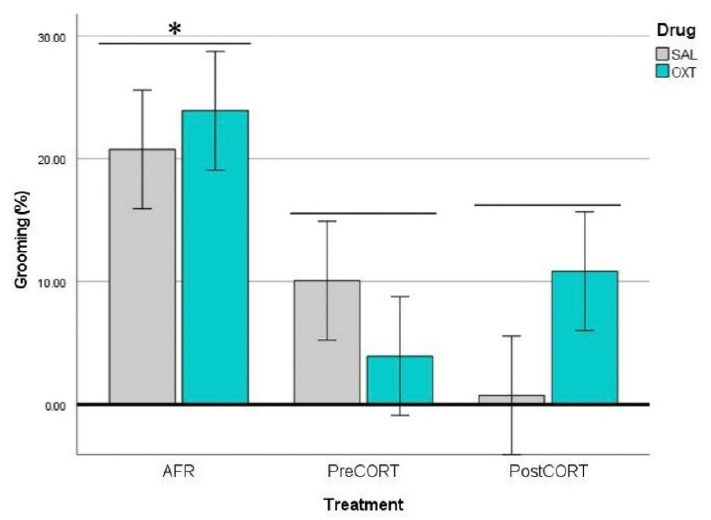
Figure 11. Percentage of Hole-probe behaviour exhibited by Demonstrators. Demonstrator mice Figure 10. Percentage of self-grooming exhibited by Demonstrator mice. Demonstrators ( n = 16) ( n = 16) were free to spend time close to each of the three Observer companions, each one belonging when found in proximity of three Observer companions, each belonging to a different perinatal to a different perinatal treatment. Observers received either intranasal administration of oxytocin treatment. The Observers were administered either intranasal oxytocin or received saline. Demon- before testing or received saline. Demonstrator mice spent a significant higher amount of time strator mice exhibited, as a whole, an important reduction in the rate of self-grooming when close to both PreCORT and PostCORT Observers than to the AFR control group (* p < 0.05). This was interacting with PostCORT subjects, in comparison with AFR subjects (* p < 0.05). Intranasal regardless the drug Observer companions received before the test. Error bars indicate mean ± oxytocin administration to the Observers did not apparently affect this profile. Error bars indicate SEM . mean ±